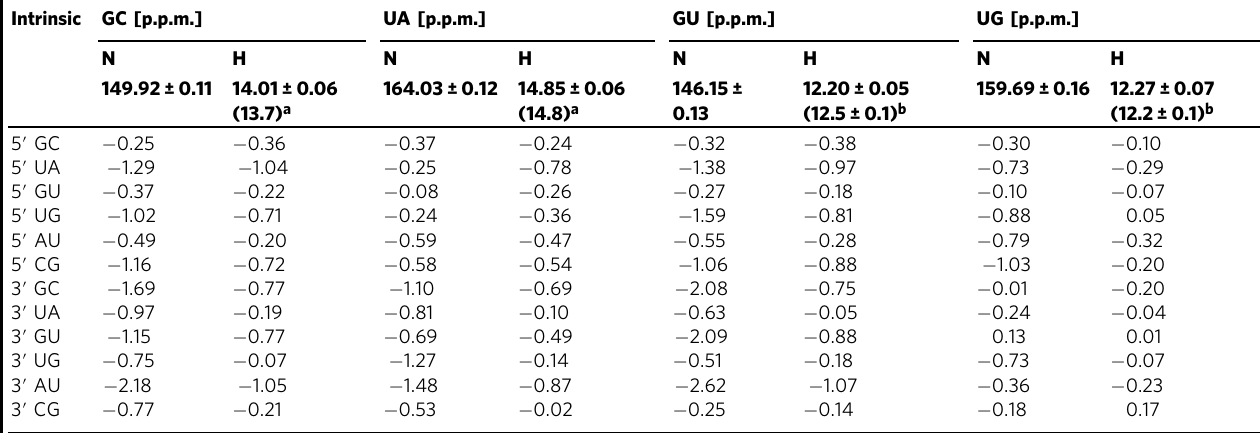
The table header shows the central base pair types and the relevant spins. The intrinsic chemical shifts reported by previous studies ( a , ref. 27 and b , ref. 28 ) are shown in